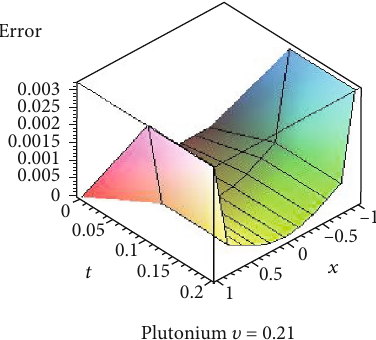
Plutonium 𝜐 = 0.21